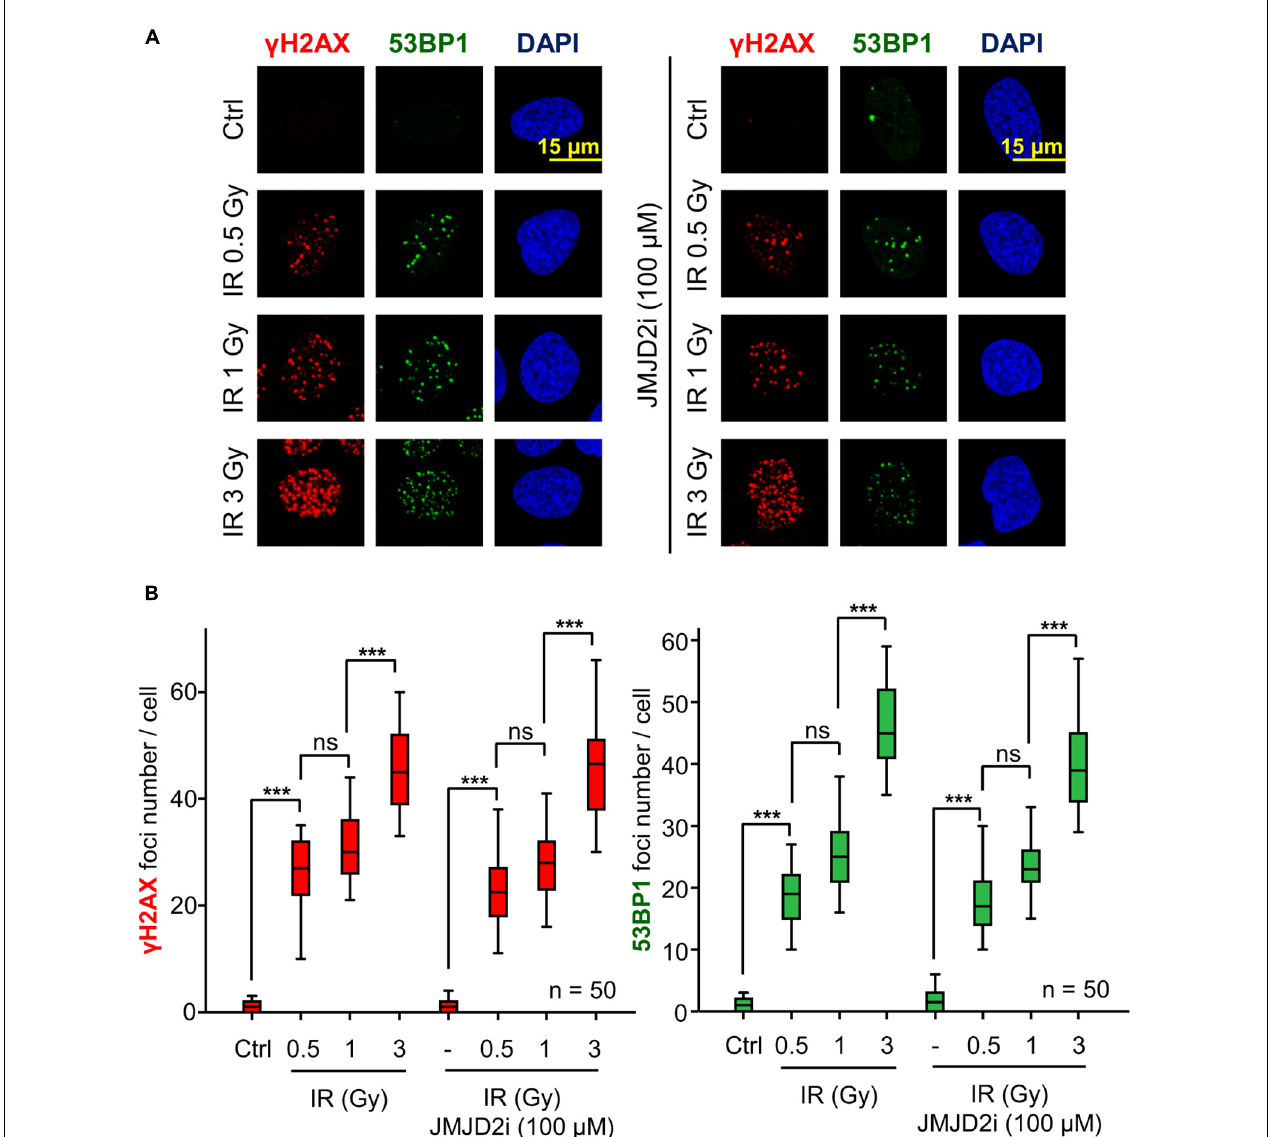
FIGURE 8 | The assembly of 53BP1 foci is not affected by JMJD2i treatment, which inhibits lysine demethylation, after inducing DSBs with IR in U2OS cells. (A) γ H2AX and 53BP1 foci formation in response to JMJD2 inhibitor and/or IR. (B) Quantification of γ H2AX and 53BP1 foci after JMJD2i treatment and inducing DNA damage by IR. ns, not significant, *** p < 0.001. The field images are shown in Supplementary Figure 10 . Ctrl, control without